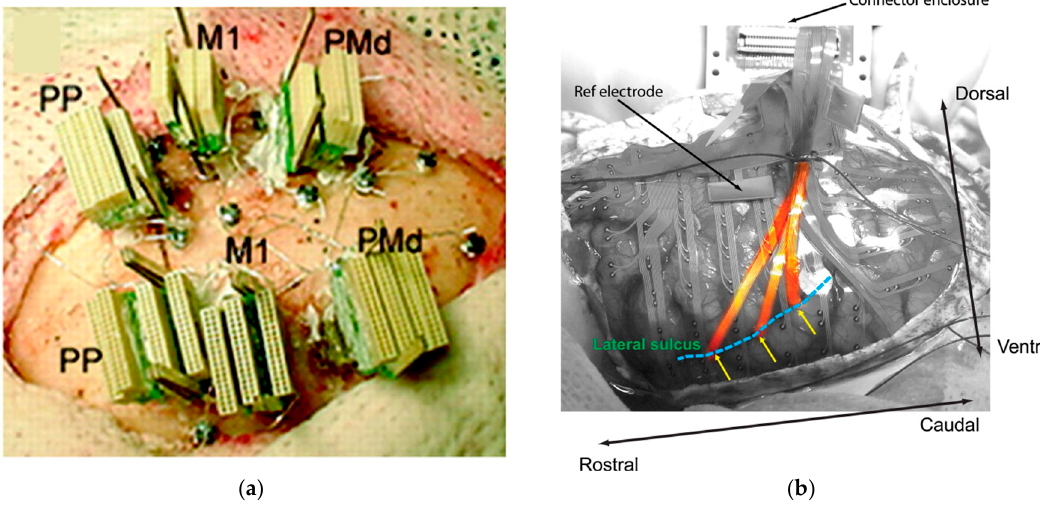
Figure 3. ( a ) Multisite 672-microwire implant; ( b ) ECoG Electrodes on the lateral sulcus surface. ( a ) Reproduced with permission from [100], Copyright 2003 National Academy of Sciences; ( b ) Reprinted from [101]. Copyright 2014, with permission from